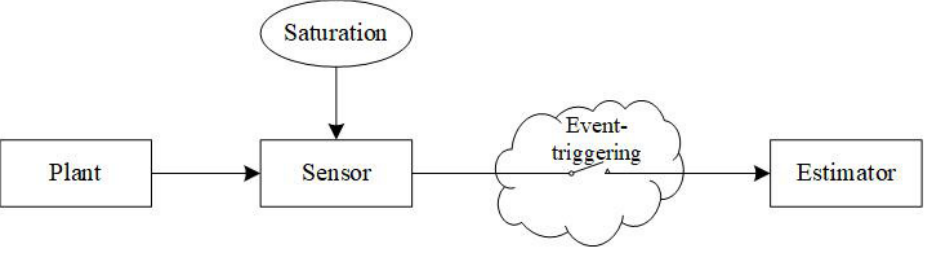
Figure 1. Structure of the state and fault